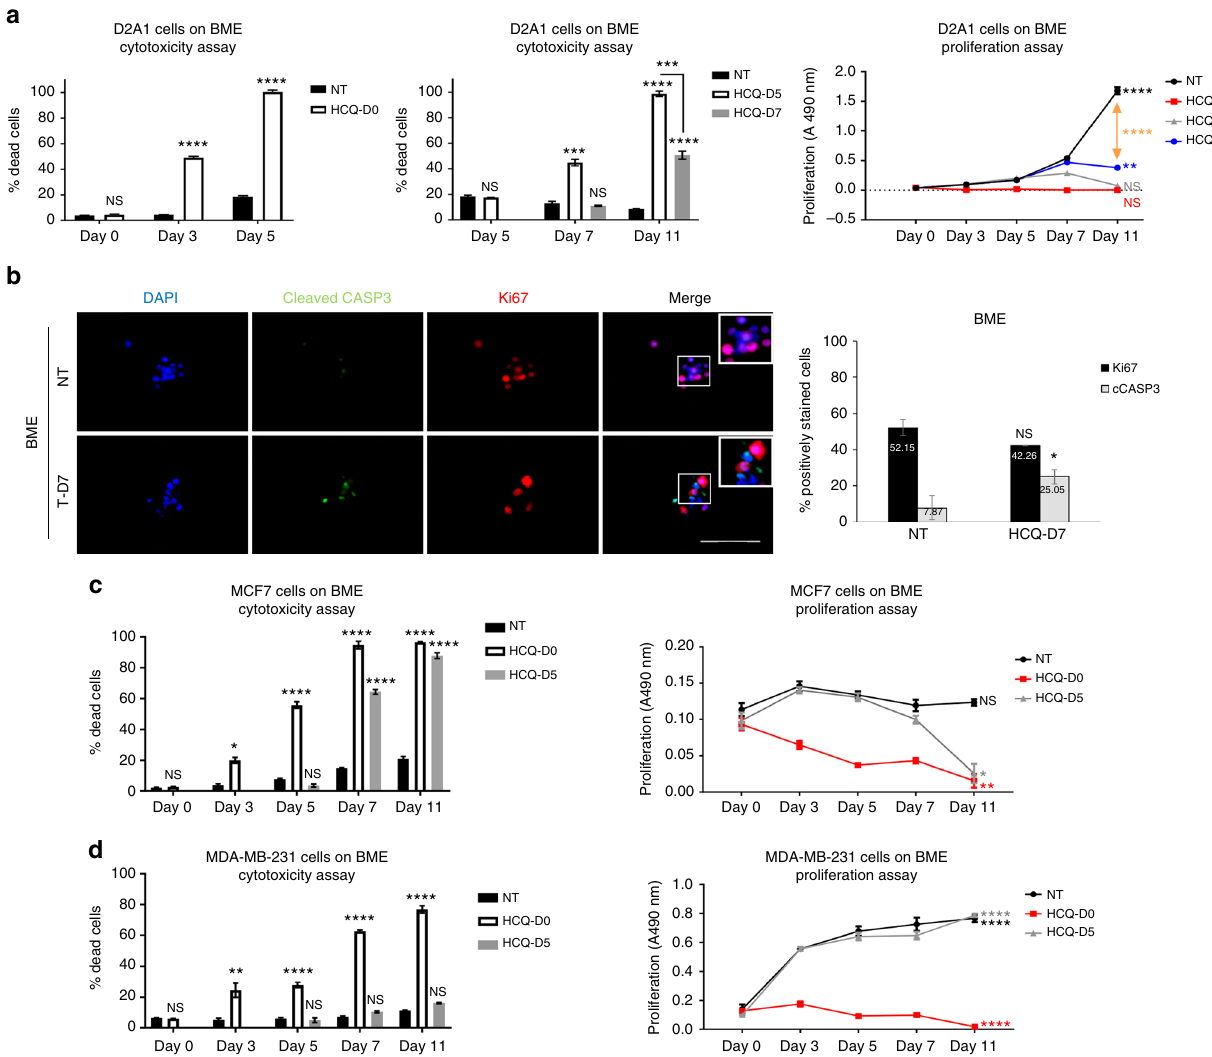
Fig. 3 Inhibiting autophagy reduces proliferative switch in 3D culture. Figure shows data of one out of three independent experiments done in triplicate with equivalent results. a 50 µ M Hydroxycholoroquine (HCQ) signi fi cantly reduced the proportion of viable D2A1 cells on BME during quiescence (treatment at day 0 (D0), left panel), which is attenuated when treated after the dormant-to-proliferative switch (day 5 (D5) or day 7 (D7), middle panel) as determined by cytotoxicity assay (mean ± s.e.m, n = 3 wells. Comparisons at day 5 (left panel) or day 11 (middle panel) by unpaired two-sided T -test. *** P ≤ 0.001 **** P ≤ 0.0001) and proliferation assays (right panel. Mean ± s.e.m, n = 3 wells. Comparisons at Day 11 by unpaired two-sided T -test. ** P ≤ 0.01 and **** P ≤ 0.0001 relative to day 0 for each group). b Representative Ki67 (red) and cleaved caspase 3 (green) immuno fl uorescence of D2A1 cells on BME treated with 50 µ M HCQ or vehicle (left panel), with quanti fi cation of markers at day 11 (right panel, mean ± s.e.m, n = 170 – 194 cells. (Mann – Whitney U - test, two-sided. * P ≤ 0.05). Scale bar is 100 μ m. c HCQ signi fi cantly reduced viable MCF7 cells on BME (left panel, mean ± s.e.m, n = 3 wells. Comparisons by two-sided unpaired T -test (Day 0 and Day 3) or one-way ANOVA plus Bonferroni post test for day 5, day 7 and day 11 time points. ** P ≤ 0.01; **** P ≤ 0.0001) and proliferation assays (right panel, mean ± s.e.m, n = 3 wells. Comparisons at day 11 by unpaired two-sided T -test. * P ≤ 0.05; ** P ≤ 0.01 relative to day 0 for each group). d HCQ did not signi fi cantly reduce the number of MDA-MB-231 viable cells on BME when treated after the dormant-to- proliferative switch (left panel, mean ± s.e.m, n = 3 wells. Comparisons by unpaired two-sided T -test (day 0 and day 3) or one-way ANOVA plus Bonferroni post test for day 5, day 7 and day 11 time points. ** P ≤ 0.01; **** P ≤ 0.0001) and proliferation assay (right panel, mean ± s.e.m, n = 3 wells. Comparisons at plating, HCQ-D5 cells treated with HCQ after 5 days in culture, HCQ-D7 cells treated with HCQ after 7 days in culture, NT